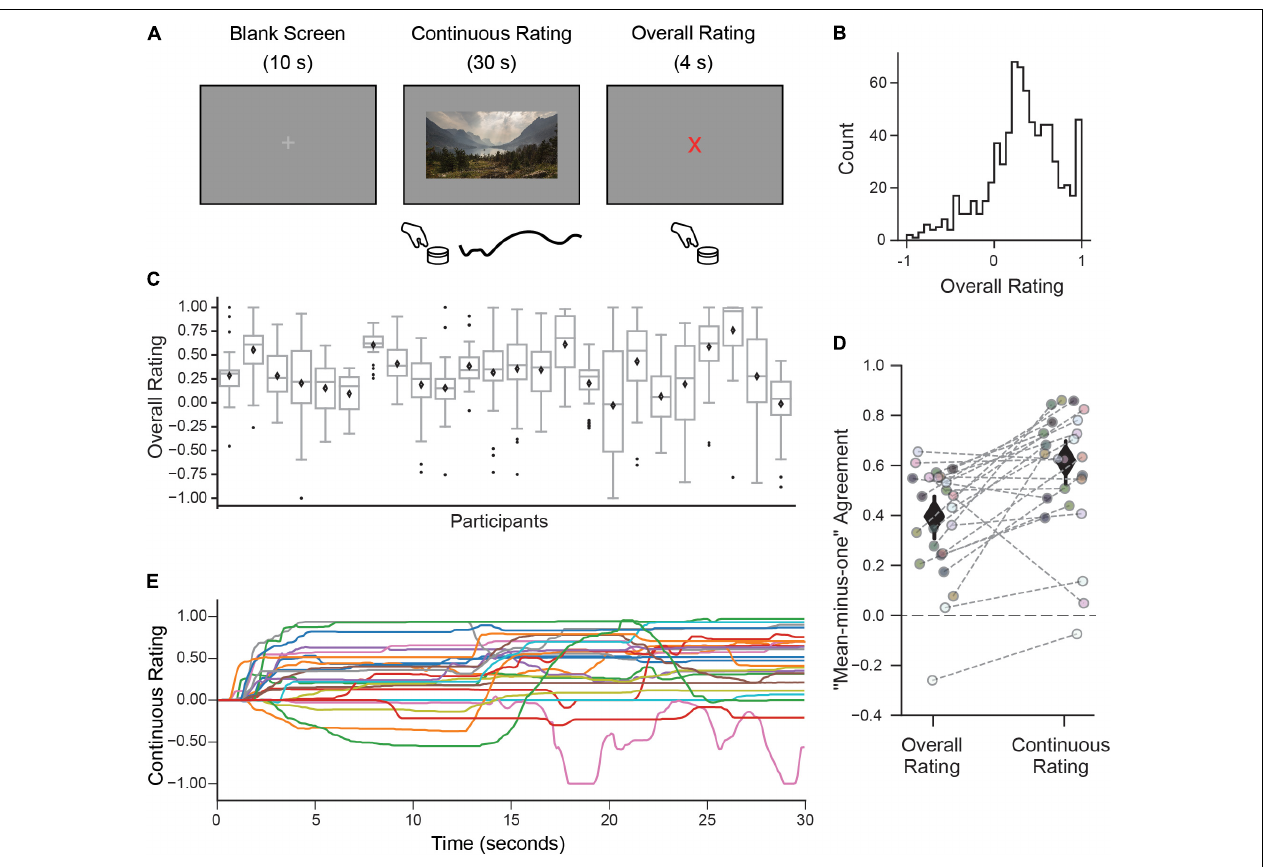
FIGURE 1 | A continuous rating paradigm for assessing individual aesthetic enjoyment of landscape videos. (A) Schematic description of one experimental trial measuring continuous aesthetic responses to dynamically changing visual experiences. Participants viewed 30 s movie clips of landscapes while making continuous ratings of their moment-to-moment enjoyment. This was followed by an overall rating indicating the intensity of the aesthetic experience from the whole movie. Both responses were given using a rotary dial. (B) The histogram of overall ratings collapsed across all participants shows that most ratings were above the ’indifference’ point (marked here as 0). (C) However, the distribution of overall ratings as illustrated with boxplots suggests marked differences across people in terms of their overall aesthetic ratings (Diamond is the mean, center line is the median, bottom and top edges of the box indicate the 25th and 75th percentiles. Whiskers extend to the most extreme data points and black circles indicate individual outliers). (D) Measure of agreement across participants (“mean-minus-one” correlation, see Materials and Methods) for overall and continuous ratings. Each circle represents the MM1 value for one participant and the gray dashed lines connect the MM1 values computed with overall and continuous ratings for the same participant. Diamonds are mean MM1 values across participants; error bars are 95% confidence intervals. (E) Continuous rating traces given by each participant for one movie clip (with the median MM1c value). In general, movie clips were rated differently by different participants, in terms of their overall mean liking and variability over